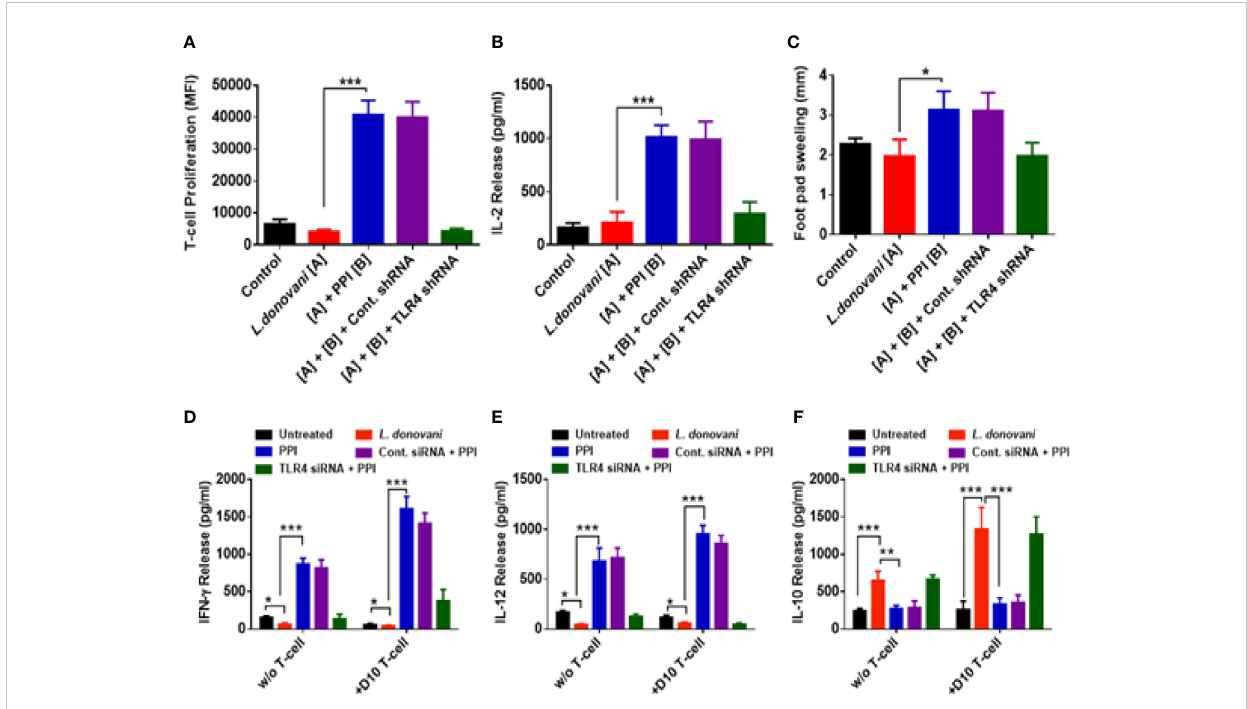
FIGURE 6 T-cell proliferation and IL-2 release in L. donovani -infected BALB/c mice treated with protein protease inhibitor (PPI). BALB/c mice (6 – 8 weeks old) were transfected with TLR4 shRNA, infected with L. donovani promastigotes, and treated with the PPI (1 mg/kg B.W.) for a total of four doses in two alternating days. On the 15th day of the last dose of treatment, the mice were sacri fi ced. Splenocytes were isolated from each group of mice and re- stimulated with 10 µg/ml of SLA for 72 (h) (A) After that, T-cell proliferation was estimated by Alamar blue assay. (B) The splenocytes were re- stimulated for 48 h with SLA as before, and the cell-free supernatant was collected, estimating the release of cytokines IL-2 using sandwich ELISA. (C) The PPI increased the DTH response in BALB/c mice. (D) IFN- g and (E) IL-12 release were increased, and (F) IL-10 release was decreased in the co-culture study. The results were expressed as mean ± SD of n = 6 animals per group. * p < 0.05, *** p <